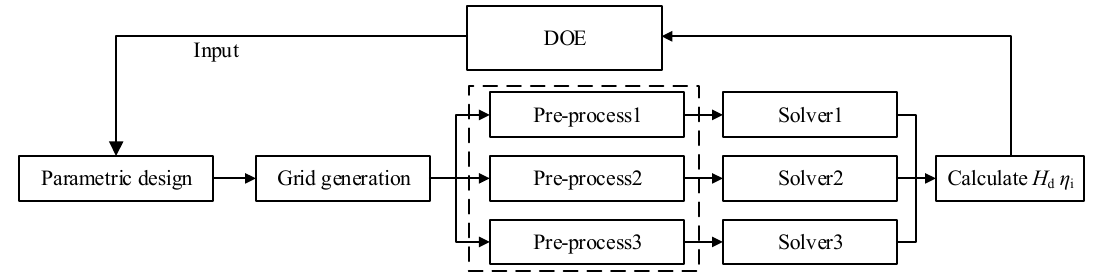
Figure 8. Operation process of the automatic optimization platform.